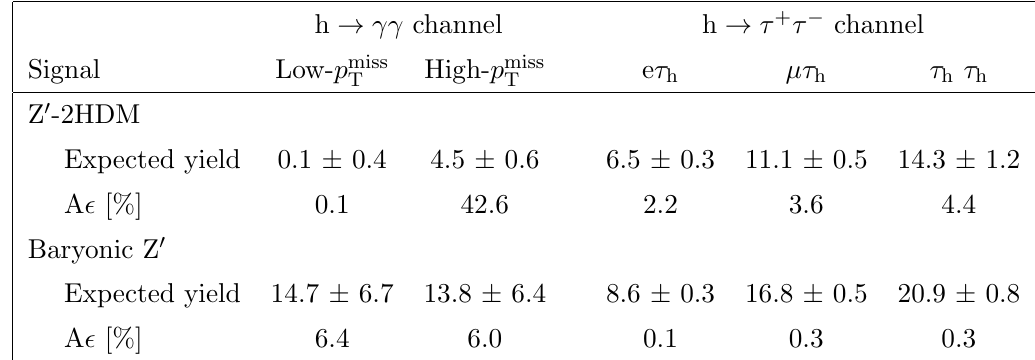
Table 7 . The expected signal yields and the product of acceptance and e(cid:14)ciency (A (cid:15) ) for the two benchmark models. The Z -2HDM signal is shown for the parameters m A = 300 GeV and m Z 0 = 0 1000 GeV, and the baryonic Z signal, for the parameters m DM = 1 GeV and m Z 0 = 100 GeV. 0